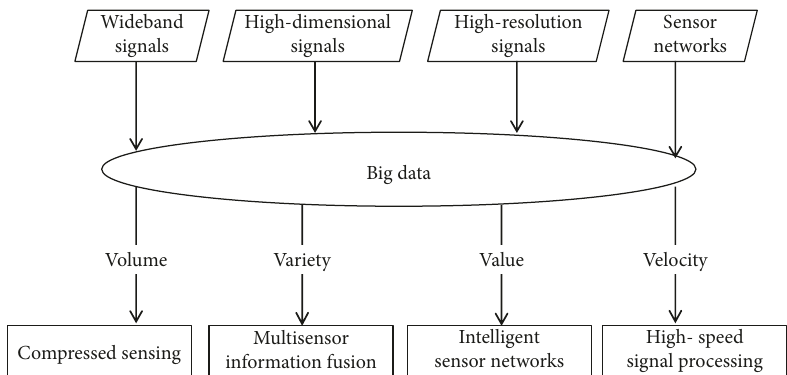
Figure 4: Signal processing in the context of big